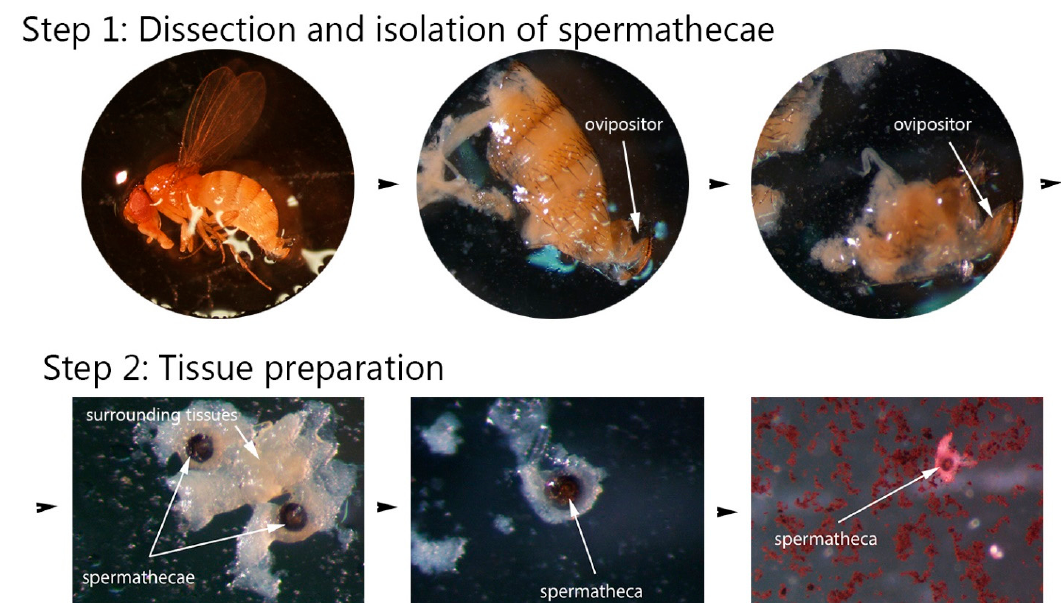
Figure 2. Basic steps of dissecting female Drosophila suzukii flies and isolating spermathecae. Step 1 includes cutting the exoskeleton of the abdomen and pulling out the reproductive system; step 2 includes removal of the spermathecal glands and surrounding tissues and staining the spermathecae (Images by Alina Avanesyan).